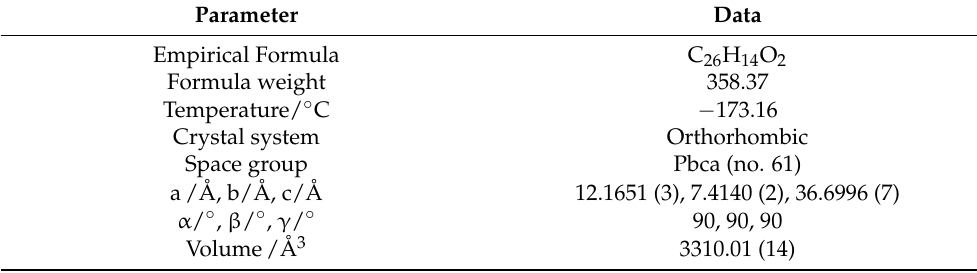
Table 2. Summary of crystal data and structure refinement.